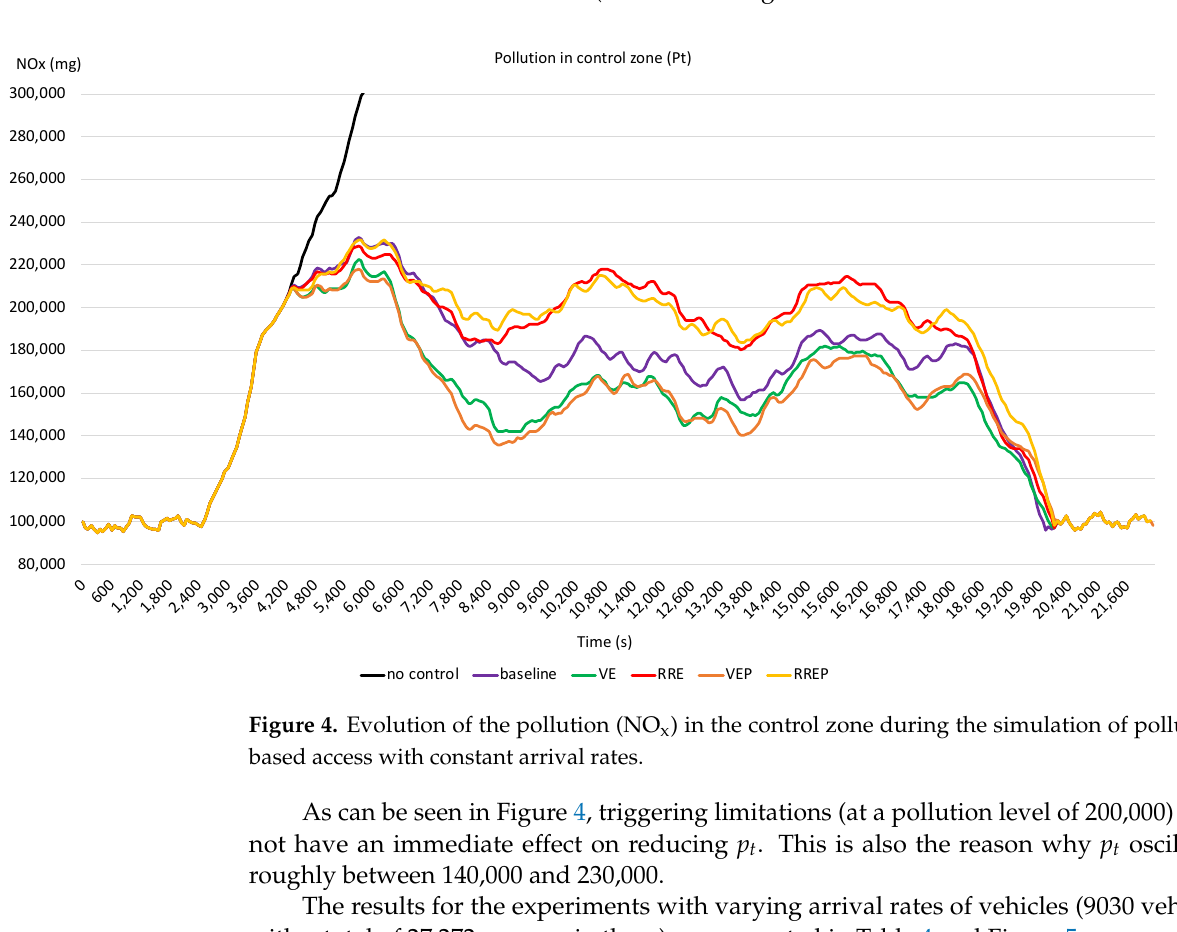
Table 3. Simulation results for pollution-based access with constant arrival rates.